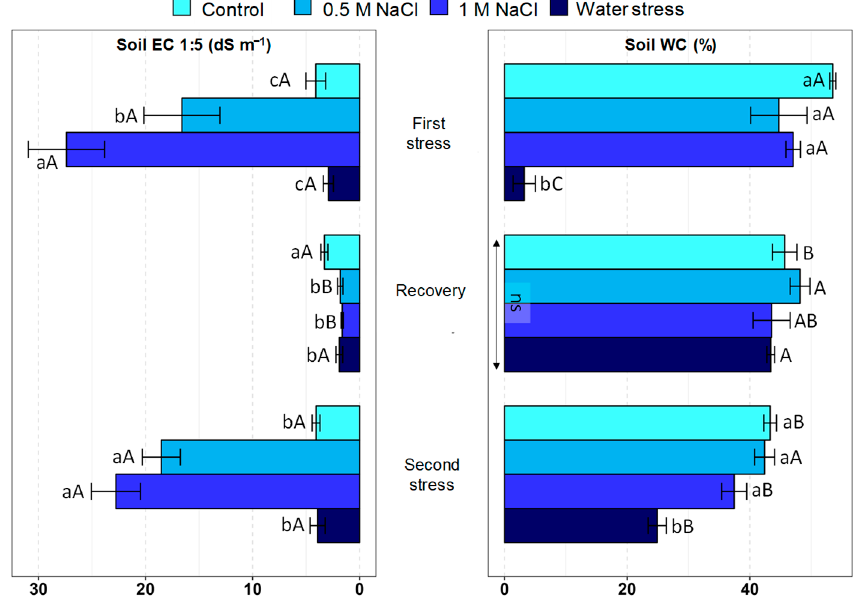
Figure 1. Effect of 30 days of stress treatment (First stress), followed by 15 days of watering with non-saline water (Recovery) and by additional 15 days of stress (Second stress) on substrate electrical conductivity (Soil EC 1:5, left ) and water content (Soil WC, right ). Different lowercase letters beside the bars indicate significant differences between treatments (Control, 0.5 M NaCl, 1 M NaCl, and Water stress) for each sampling, at p ≤ 0.05; ns: non-significant. Different uppercase letters indicate significant differences between the three sampling times (First stress, Recovery, and Second stress) for each treatment, at p ≤ 0.05; ns: non-significant. Vertical bars indicate standard error (n =